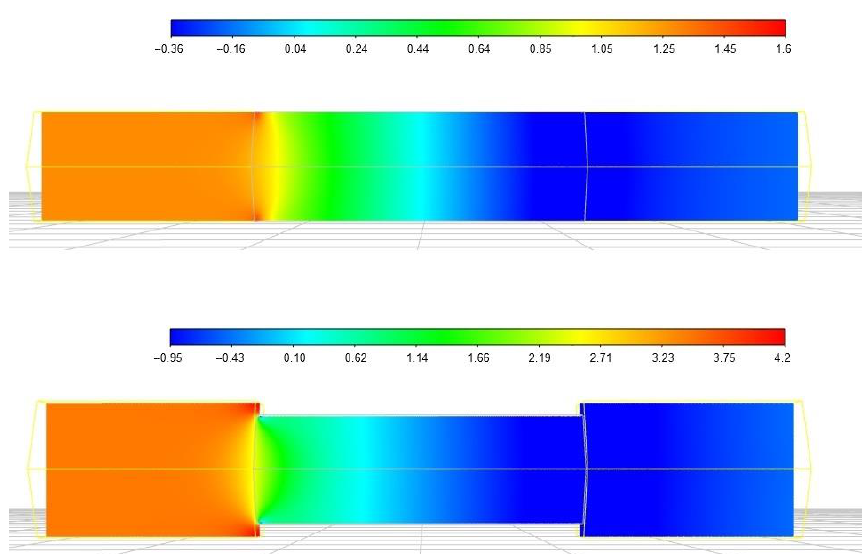
Figure 5. Distribution of static pressure along the computational domain for simplified ( top ) and real ( bottom ) models ( u 0 = 1 m ∙ s − 1 ).